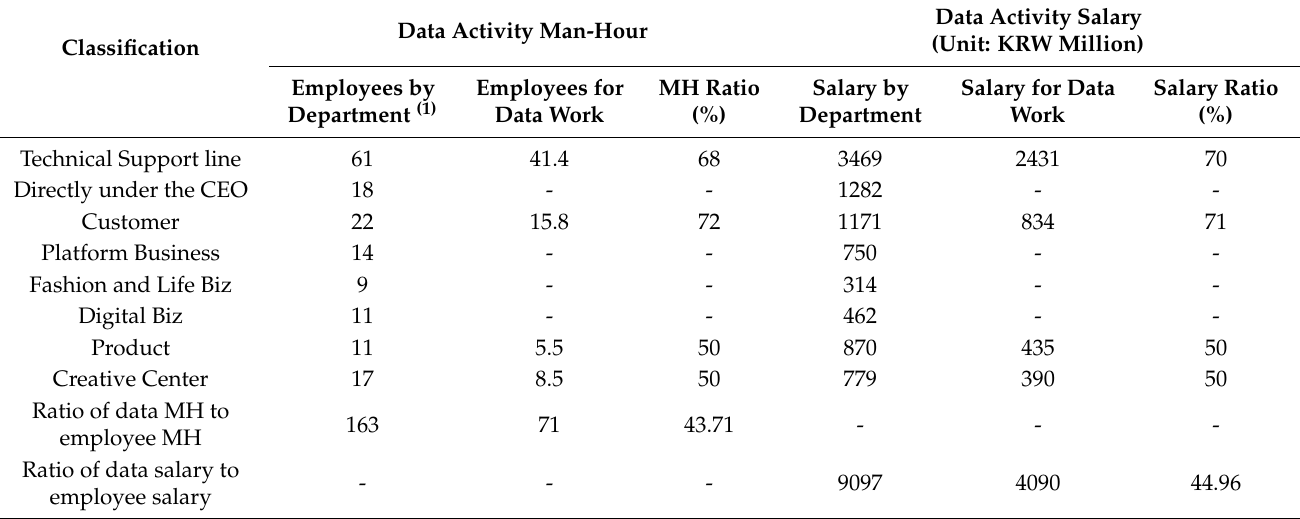
Table 7. Details of data activity ratio calculation.